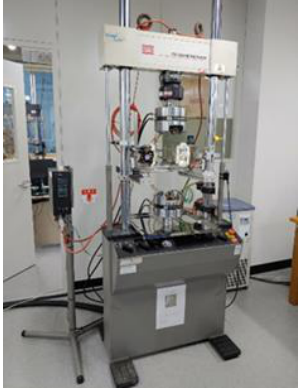
Figure 2. Test equipment